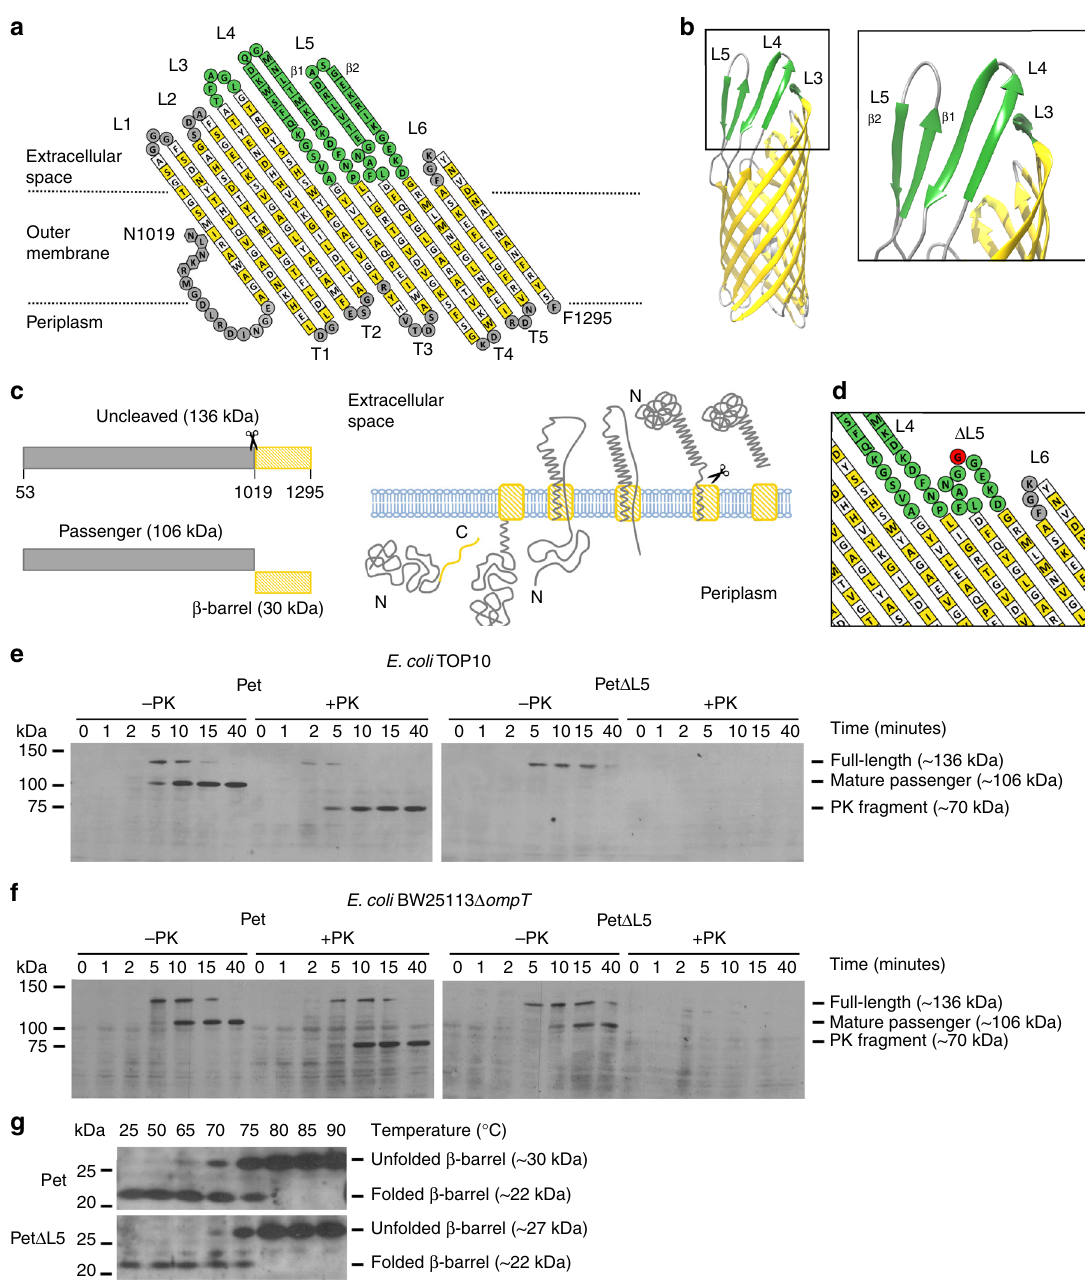
Fig. 1 Truncation of L5 affects folding of the Pet passenger domain in bacterial cells. Topology model of the Pet β -barrel domain ( a ) based on the crystal structure of the EspP β -barrel domain (PDB code 3SLJ) (these β -barrels share ~ 91% sequence identity) ( b ). The structure shows L5 in an ‘ open ’ conformation where it interacts with L4, forming a 4-stranded β -sheet. It is noteworthy that the uncleaved passenger domain that traverses the length of the pore is hidden for clarity. For a , yellow and white squares indicate residues with side chains that point toward the lipid bilayer and the β -barrel lumen, respectively. Residues in periplasmic turns labeled T1 – T5 and extracellular loops labeled L1, L2, and L6 are shown in gray, as are the residues in the α -helical segment. Residues in extracellular loops labeled L3, L4, and L5 are shown in green. Given that these loops are mobile, the alignment of L4 and L5 does not strictly follow PDB 3SLJ. c The domain structure (left) and schematic for biogenesis (right) show that, post cytoplasmic synthesis and inner membrane translocation, Pet is processed by a signal peptidase to a ~ 136 kDa polypeptide in the periplasm. The β -barrel domain of Pet is then assembled into the outer membrane to allow translocation of the passenger domain, in a C- to- N- terminal direction, until the extreme N-terminus traverses the β -barrel pore. An autocatalytic cleavage reaction within an intra-barrel α -helical segment liberates the ~ 106 kDa mature form of the passenger domain, leaving the ~ 30 kDa β -barrel domain embedded in the outer membrane. d Topology model of the Pet β -barrel domain showing the L5 truncation created by replacing E 1233 – K 1246 with one glycine residue (shown in red). Pulse-chase expression of Pet and Pet Δ L5 and sensitivity to proteinase K (PK) in E. coli TOP10 ( e ) and BW25113 Δ ompT ( f ) monitored by SDS-PAGE and immunoblotting with anti-Pet passenger domain antibodies. All samples were TCA precipitated prior to SDS-PAGE. g Heating of total membranes containing Pet and Pet Δ L5 at the temperatures indicated. Samples were analyzed by SDS-PAGE and immunoblotting with anti- β -barrel domain antibodies. Images are representative of at least two independent